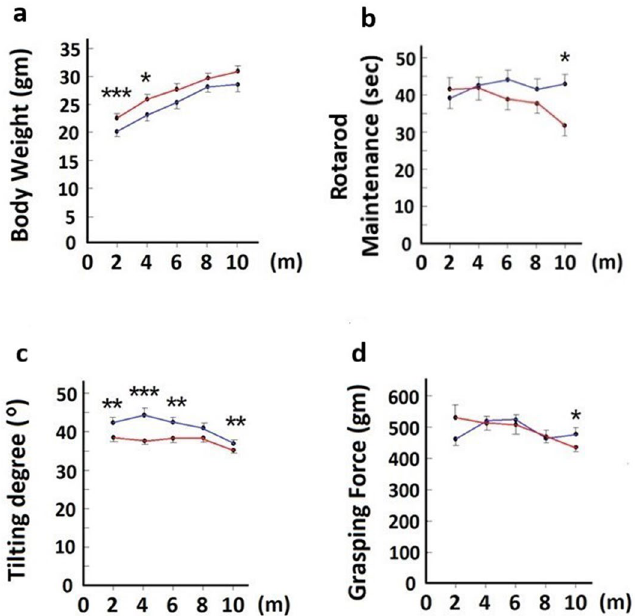
Figure 4. Comparison of motor ability in SMA mice with or without hAFSC transplantation. n = 16. (a) Body weight of SMA mice. (b) Rotarod maintenance time of SMA mice. (c) Tilting degree of wooden platform which SMA mice could hold on. (d) Grasping force of forearms of SMA mice. hAFSC human amniotic fluid stem cell; SMA spinal muscular atrophy. Blue line: SMA mice with hAFSC transplantation; Red line: SMA mice without hAFSC transplantation. Body weight and result of three behavioral tests were documented every two months after hAFSC transplantation. SMA mice with hAFSC transplantation has lower body weight during whole study. In all three behavioral tests, SMA mice with hAFSC transplantation has better performance during whole study.